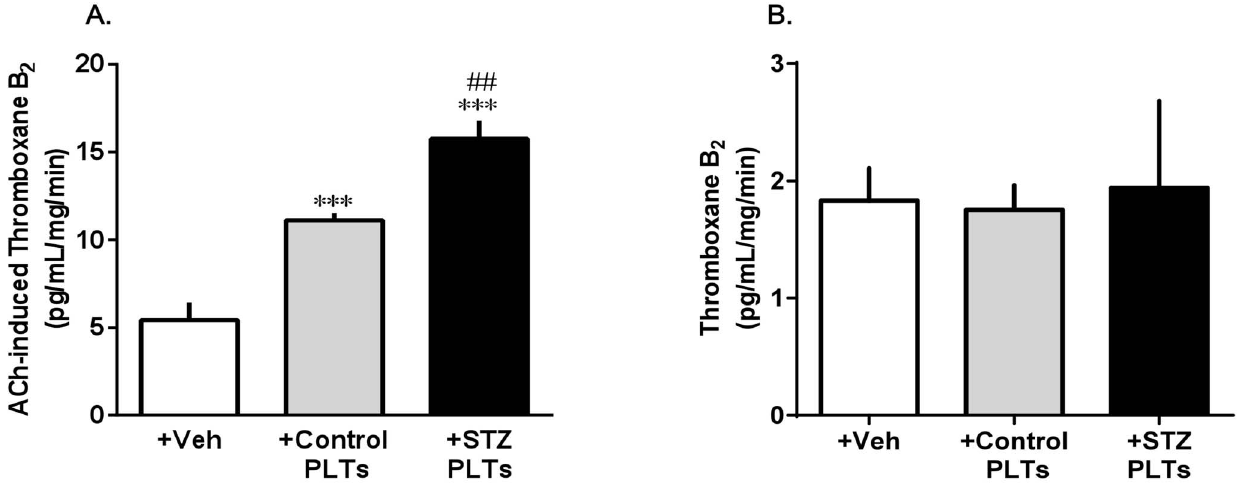
Figure 4. Release of TXB 2 (stable metabolite of TXA 2 ) under non-stimulation (A) or ACh-stimulation (B) in carotid arteries. Control carotid arteries were incubated for 30 min at 37 u C with vehicle (saline) or 1.65 6 10 7 cells/mL of control or STZ PLTs before this experiment. (B) TXB 2 production in each treated or untreated carotid artery from control or diabetic rats with ACh (10 2 6 M) stimulation. Data are means 6 SE; n=5–6. ***P , 0.001 vs. Control + Veh (only ACh-treated carotid arteries from control). ## P , 0.01 vs. Control + Control PLTs.